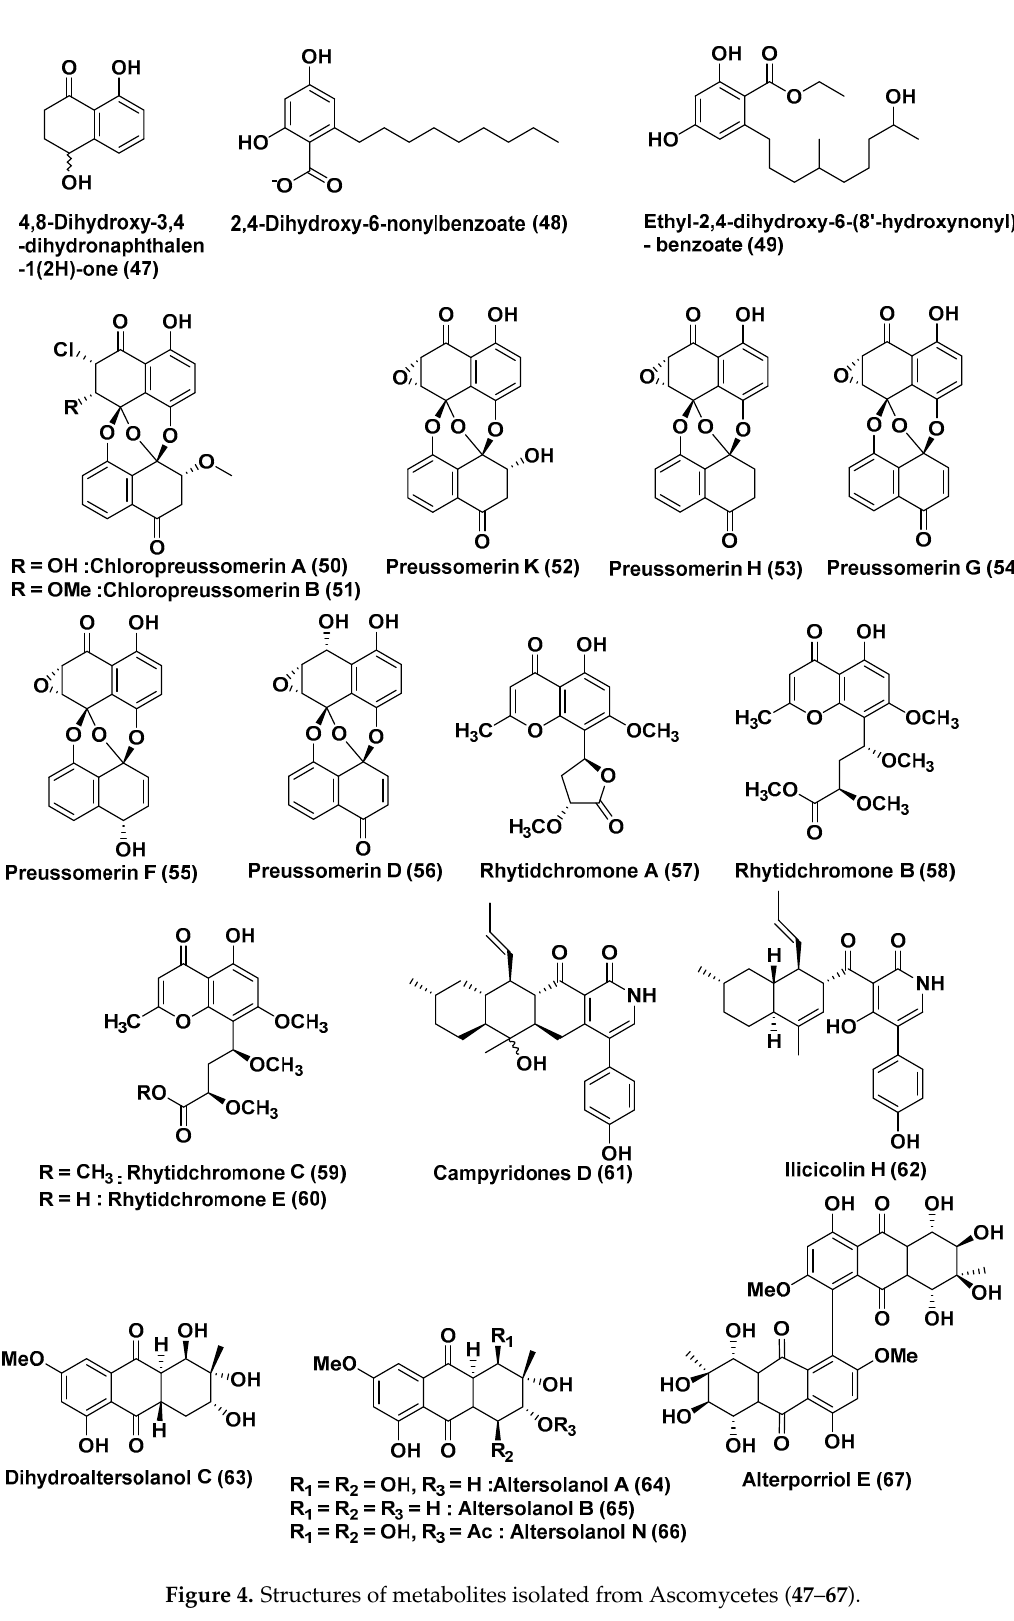
Figure 4. Structures of metabolites isolated from Ascomycetes ( 47 – 67 ).